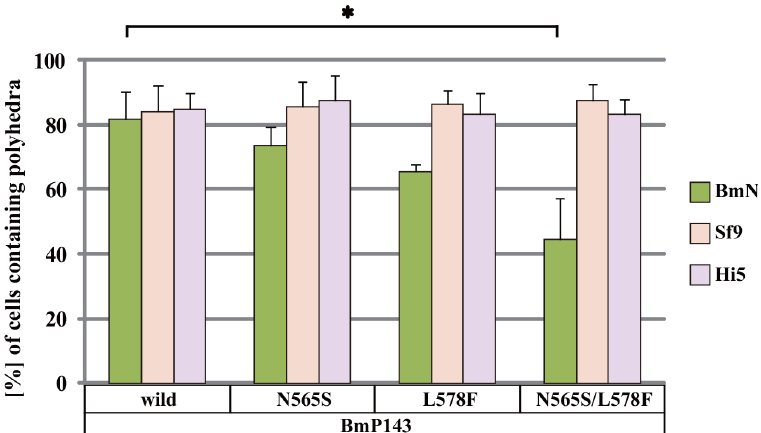
Fig 2. Effect of authentic BmP143 promoter-driven BmP143 recombinant proteins on polyhedron formation. BmN, Sf9 and Hi5 cells were transfected with plasmids expressing the BmP143 recombinant proteins indicated. The transfected BmN cells were infected with wild-type BmNPV and the transfected Sf9 and Hi5 cells were infected with wild-type AcMNPV. At 72 hpi, the proportion of polyhedron-containing cells was calculated under a fluorescence microscope. Average of three experiments ± SEM are shown. Student's t -test: ( * ) p < 0.05. ANOVA: BmN p = 0.0098; Sf9 p = 0.959; Hi5 p =